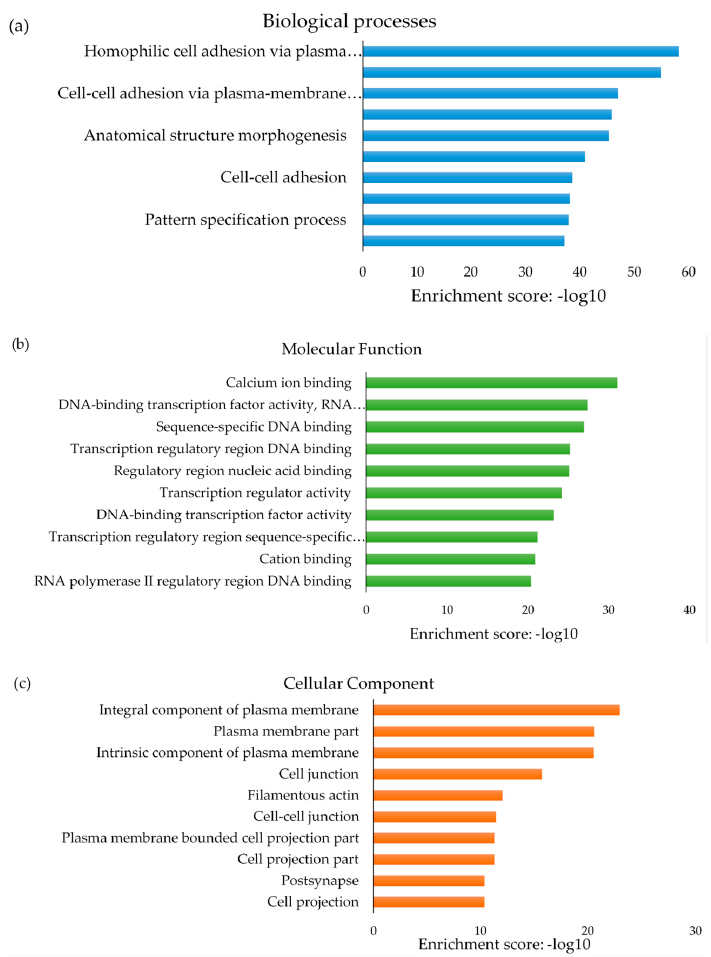
Figure 6. Top 10 Gene Ontology (GO) terms enriched by differentially methylated genes in GDM and non-GDM groups. Enriched GO terms were categorized into ( a ) biological processes, ( b ) molecular function and ( c ) cellular components. Data are presented as enriched scores expressed as − log10 ( p value). Fisher p ≤